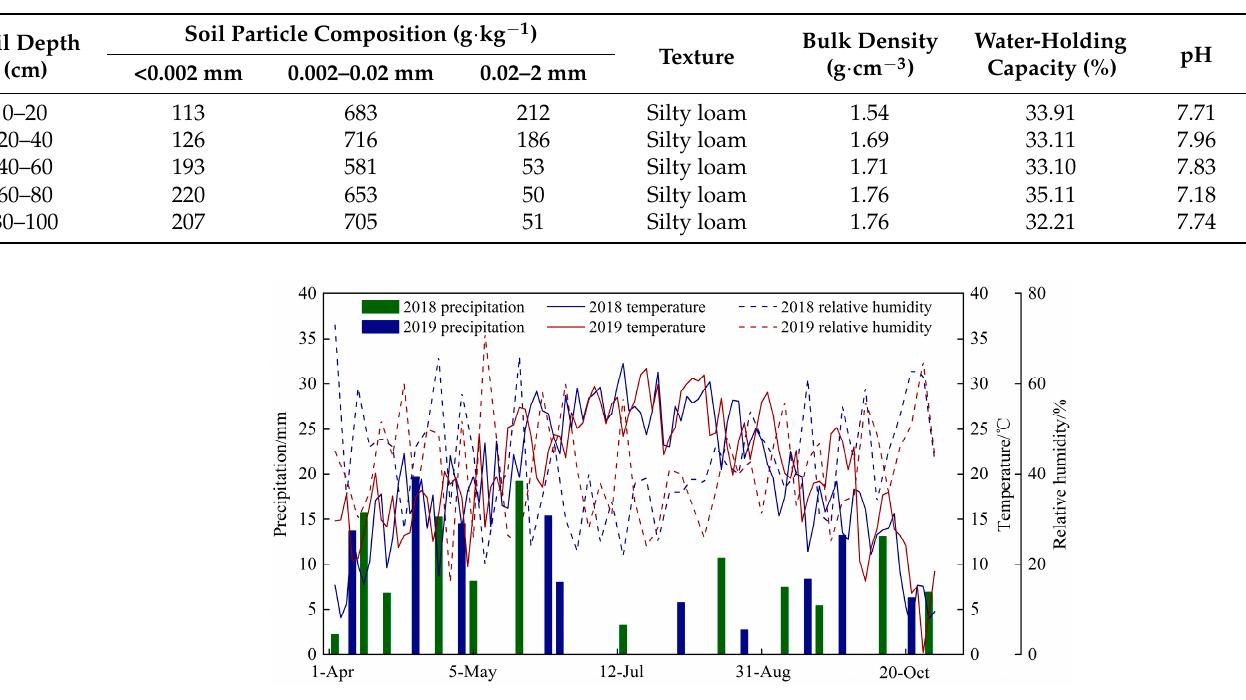
Figure 2. Daily meteorological variation during cotton growth periods (1 April to 30 October) in 2018 and 2019. Table 1. Physical and chemical properties of soil at the test site.